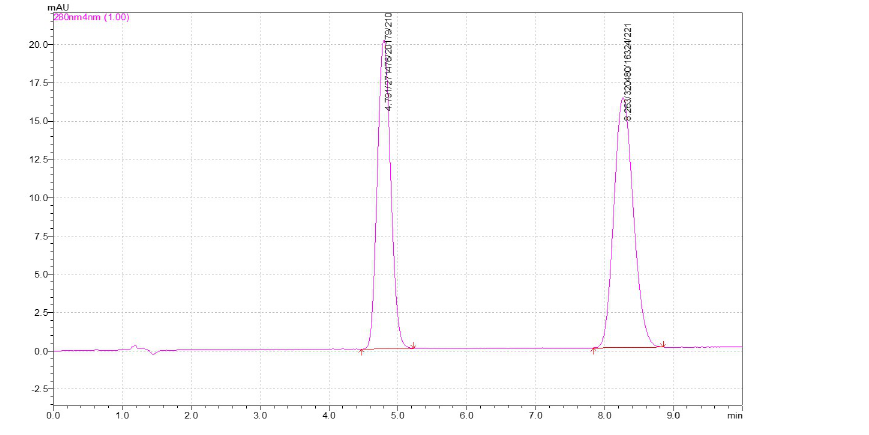
Fig 2. Chromatogram of 1-naphthol and 1-naphthol acetate on the developed method.